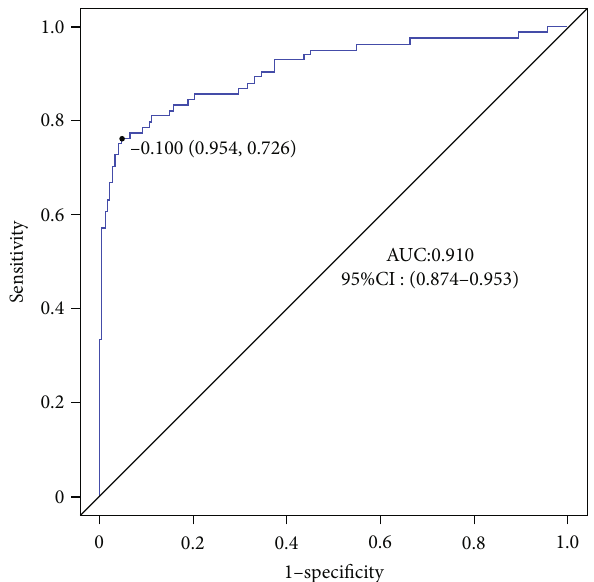
Figure 3: The ROC curve of the nomogram model for predicting postoperative recurrence of POP.